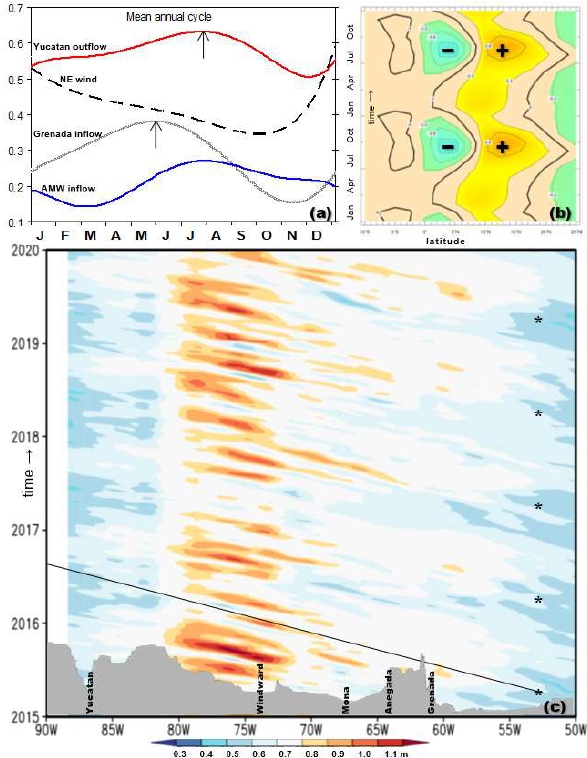
Figure 5. ( a ) Mean annual cycle of inflows and outflow (m/s) and NE winds ÷10 (+ westward m/s); arrows highlight two-month lag. ( b ) Hovmoller plot of the mean annual cycle ×2 of surface wind vorticity (10 −4 s −1 ) averaged over the east Atlantic 15–45°W (+ cyclonic). ( c ) Hovmoller plot of daily SSHdt along 16° N in the period 2015–19, revealing annual troughs ( * ) and intra-seasonal crests of ocean Rossby waves propagating westward at 0.1 m/s (line) with schematic bathymetry and passages (lower).